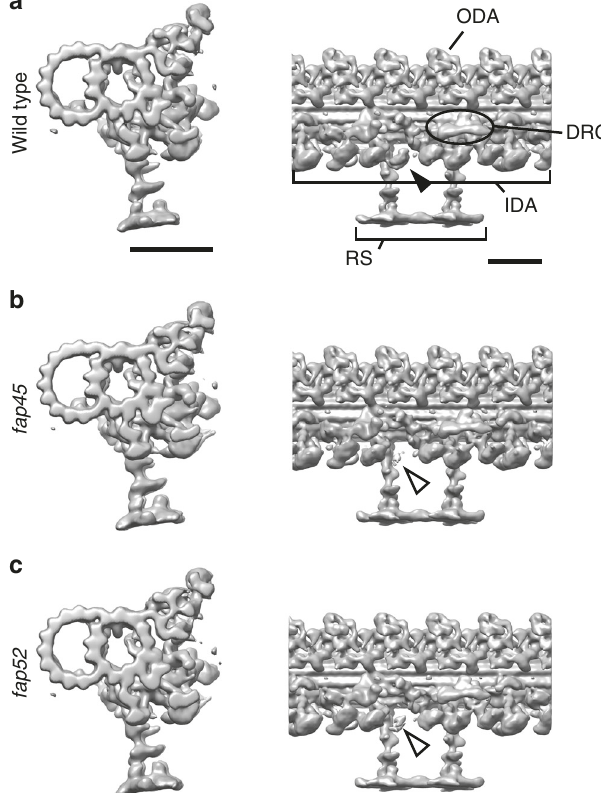
Fig. 2 Dynein b density is reduced in the fap45 and fap52 DMT. Isosurface renderings of averaged DMT repeats: wild type ( a ), fap45 ( b ), and fap52 ( c ). The density of dynein b is decreased in fap45 and fap52 (arrowheads). Other species of IDAs, ODAs, RS, and N-DRC were properly arranged on the DMT in fap45 and fap52 . Scale bar = 25